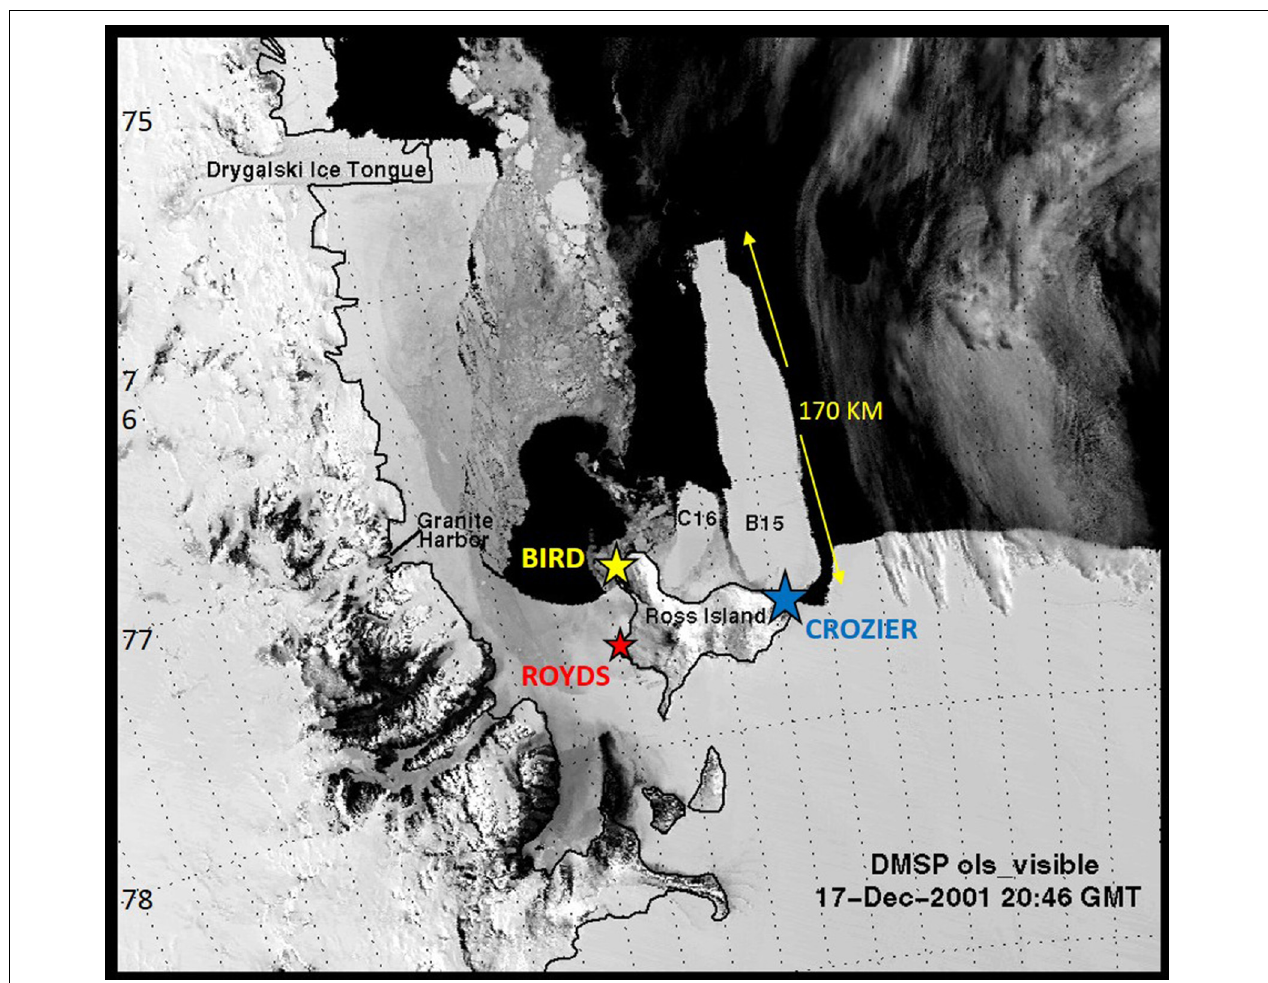
FIGURE 1 | Southern Ross Sea, Antarctica, and the locations of three Adélie penguin breeding colonies on Ross Island where reproductive performance parameters were collected from 1997 through 2010. Colonies vary in size by orders of magnitude, with